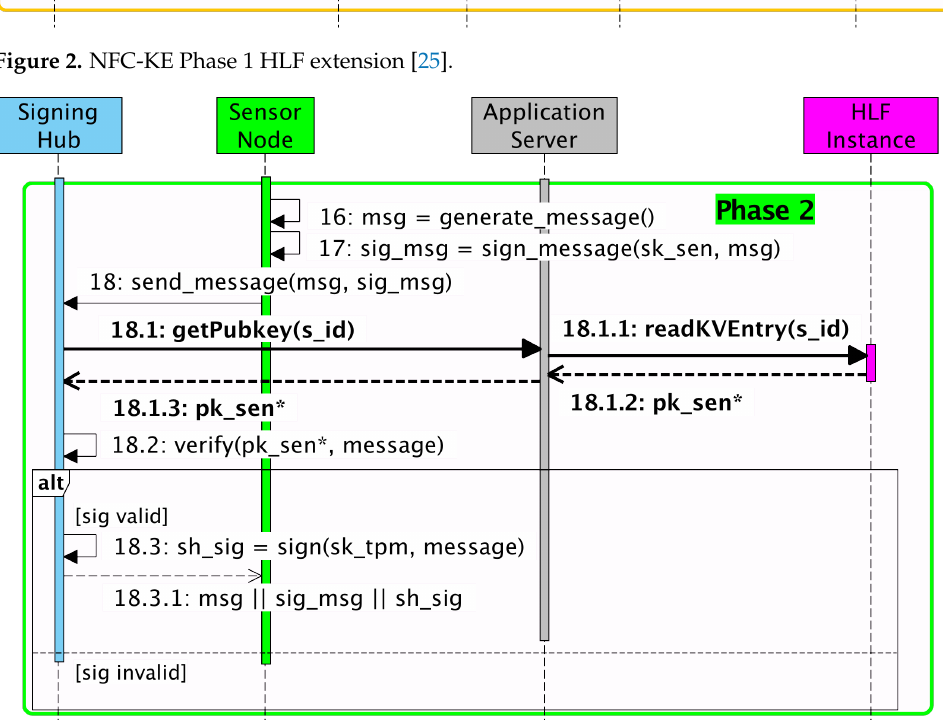
Figure 3. NFC-KE Phase 2 HLF extension